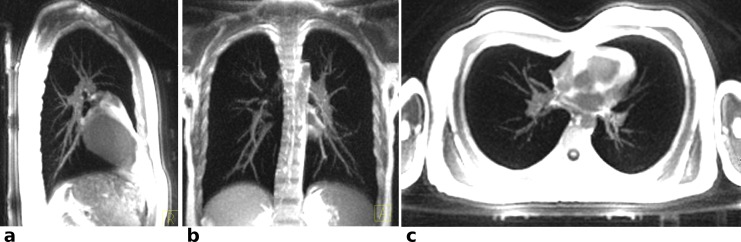
UTE single breath-hold lung imaging: Maximum intensity projections of UTE lung images over 20 mm of a healthy volunteer.The original images were acquired with an isotropic resolution of (1.8 mm)3 at 39% Nyquist sampling within a single breath hold of 29s. In (a) and (c) parts of the spine coil and the scanner table are seen. Due to the large FoV some image distortions are visible towards the edges of the images.